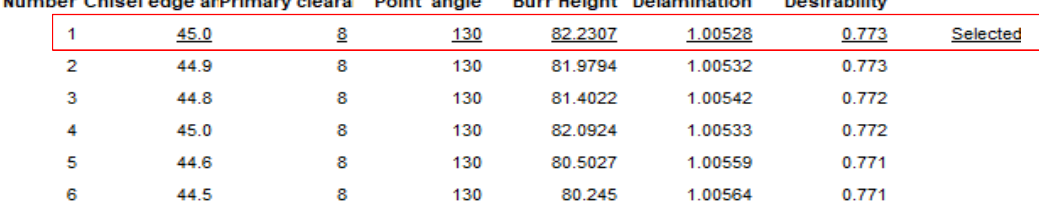
Figure 17. Proposed solution report for the optimization tool geometry process. Table 7. Prediction of the optimized model of twist drill bit for edge defect analysis when drilling CFRP/Al7075-T6 stack-up material.